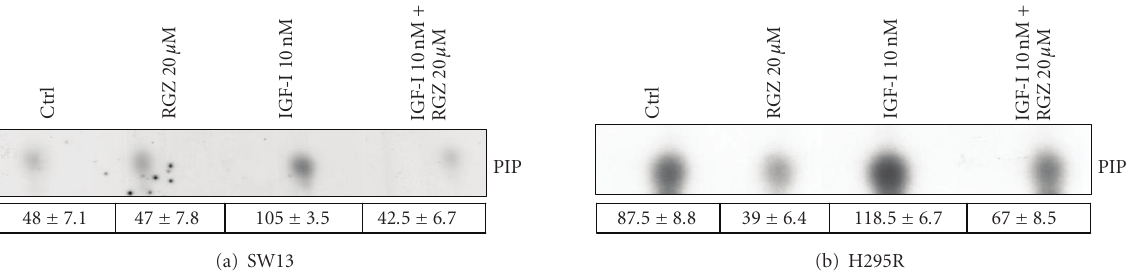
cell proliferation in the presence of IGF-I compared to NVP + IGF-I (Figures 7(b), 7(c)) suggesting that RGZ growth inhibition is mediated via IGF-IR